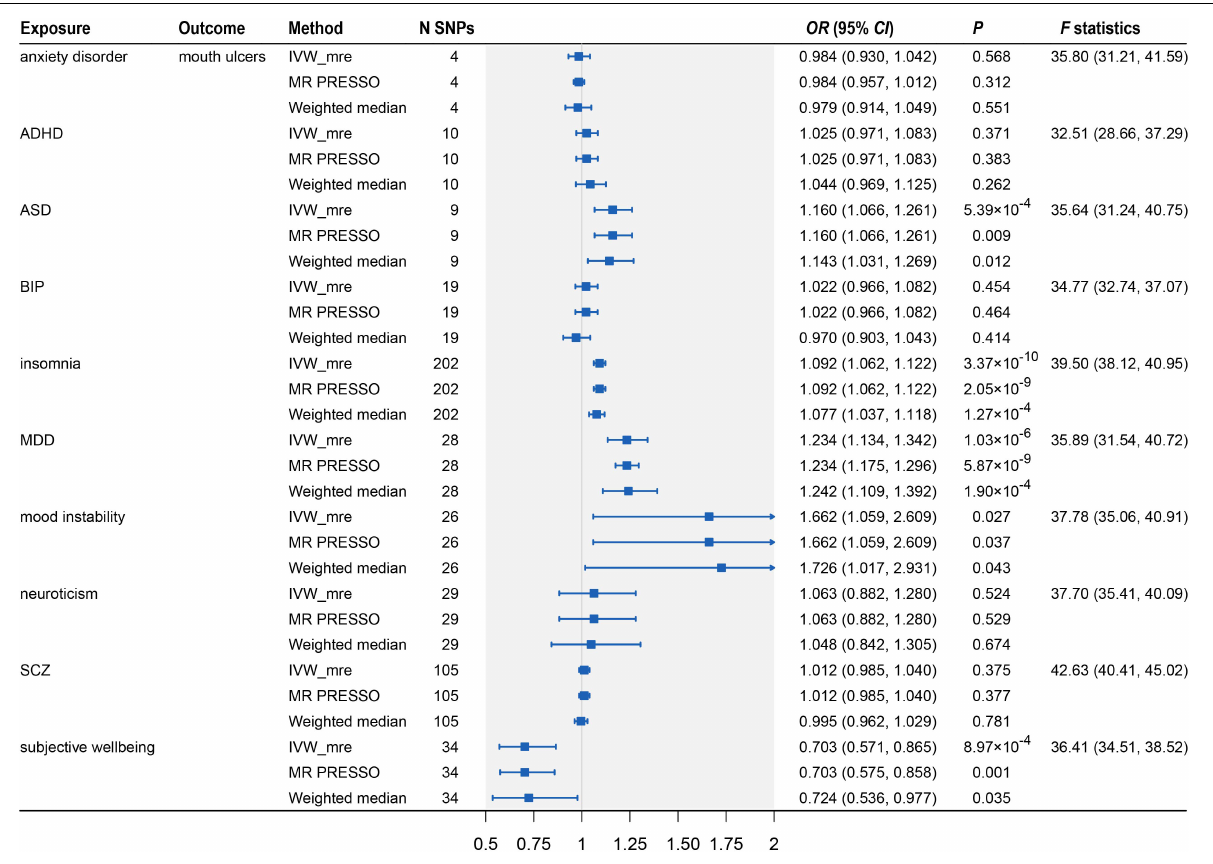
FIGURE 3 | Two-sample Mendelian randomization analyses showing the effect estimates of 10 psychiatric traits on mouth ulcers. ADHD, attention deficit/hyperactivity disorder; ASD, autism spectrum disorder; BIP, bipolar disorder; MDD, major depressive disorder; SCZ, schizophrenia; IVW_mre, inverse variance weighted with multiplicative random effects; MR-PRESSO, Mendelian randomization pleiotropy residual sum and outlier; N SNP, number of the instrumental SNPs used to conduct MR analyses; Effect estimates express the change in odds ratio ( OR ) per standard deviation (SD) increment in psychiatric traits, error bars indicate 95% confidence